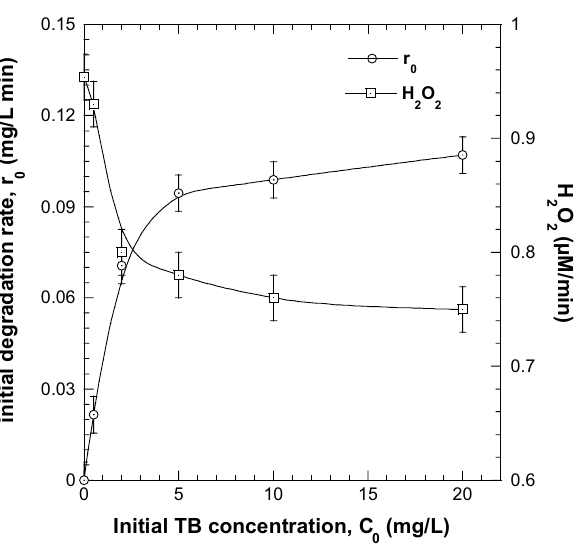
Fig. 6 Degradation kinetics of TB for various initial concentra- tions (conditions—volume: 100 mL, initial TB concentration: 0.5–20 mg/L, temperature: 25 ± 2 °C, pH ~ 6, frequency: 1700 kHz, power: 15 W)